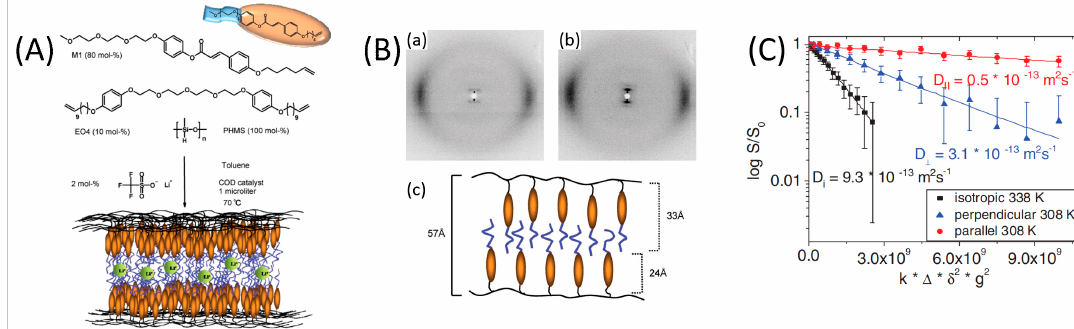
Figure 12. Synthesis of an elastomer loaded with Li-ions from a smectic LC network. ( A ) The used LC monomers and Li-salt, and an illustration of the conductive LC elastomer; ( B ) XRD pattern of elastomer without Li (a) and with Li incorporated (b) including a schematic of the interdigitated SmA layers (c); ( C ) Measurements of 7 Li diffusion coefficients parallel and perpendicular to the director of the Li-elastomer at 308 K, and in the isotropic phase at 338 K. Adapted from [33], licensed by John Wiley and Sons, Inc. (Hoboken, NJ, USA).